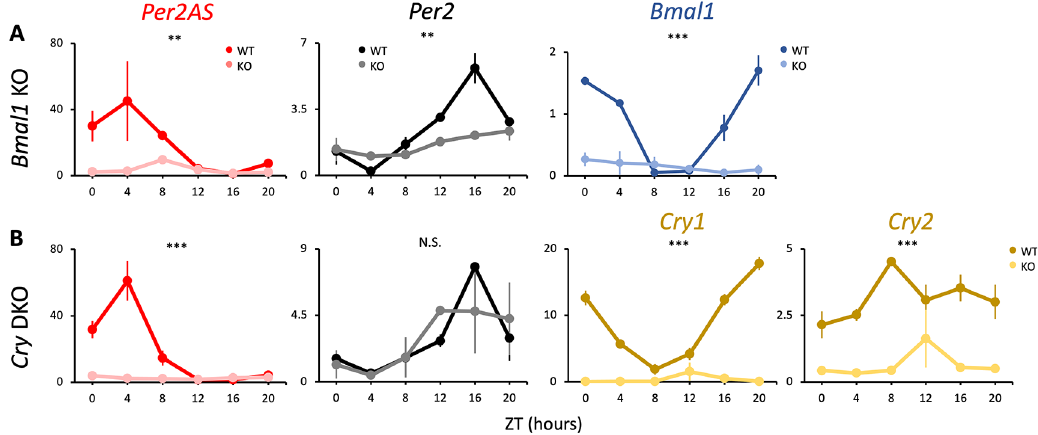
Figure 3. The expression patterns of Per2AS and Per2 with time-restricted feeding (TRF). Mice were kept under an L:D=12:12 cycle and access to food were restricted between ZT12 to ZT24. Liver RNAs were extracted every four hours in (A) Bmal1 and (B) Cry1/2 double knockout mice. Y-axis represents strand-specific TPM. Points and error bars represent mean (cid:2) SE (n=2). (**) p<0.01, (***) p<0.001, N.S. indicates no significant difference between genotypes (two-way ANOVA). Data derived from Weger et al ., Proc Natl Acad Sci U S A , 2020.